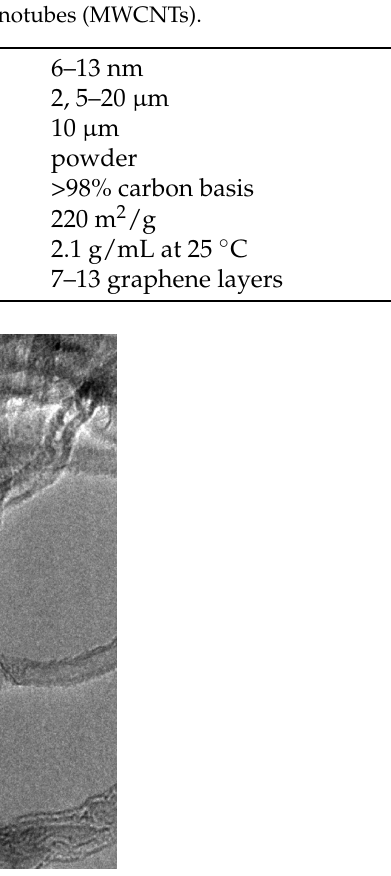
Figure 1. Transmission electron microscope image of MWCNT, adapted with permission from Sikora et al. (2019)